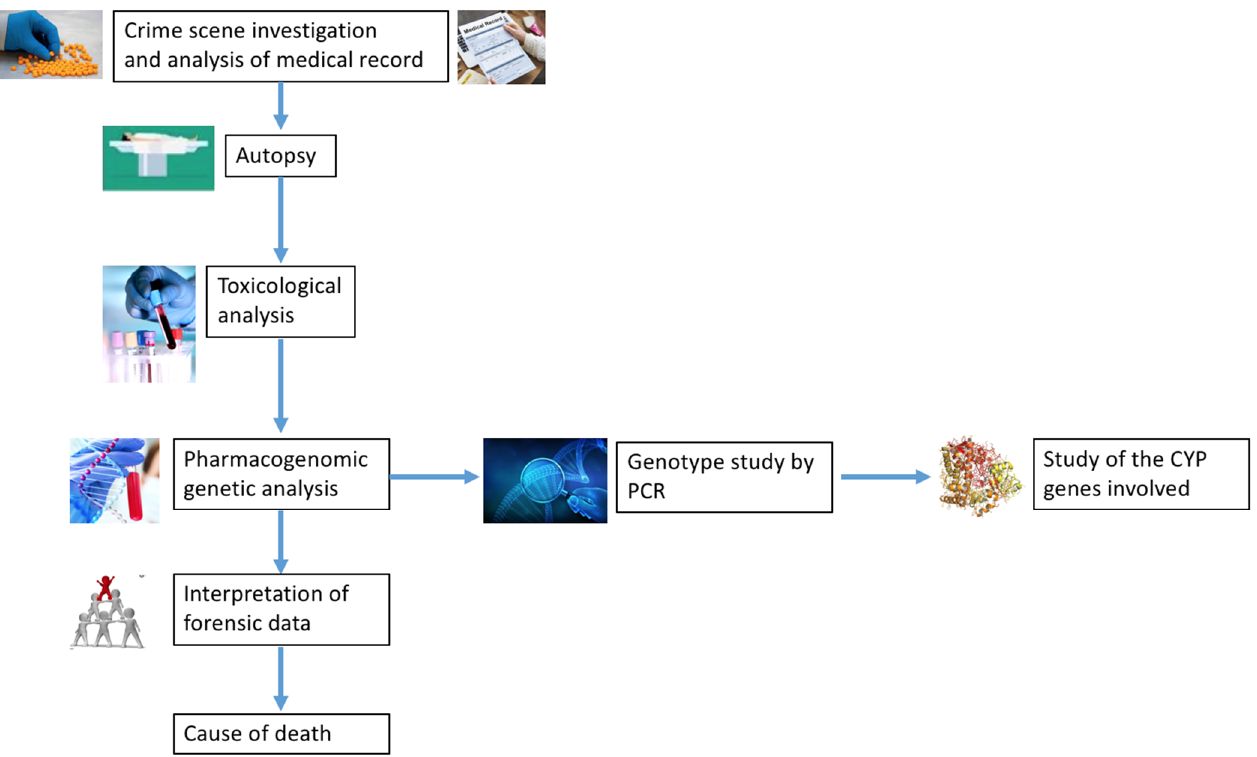
Figure 2. Investigative protocol for cases of suspected death related to the administration of drugs or abuse of substances. It is necessary to perform a DNA investigation, through a PCR test, analyzing the CYPs involved for the substance suspected of having been administered.